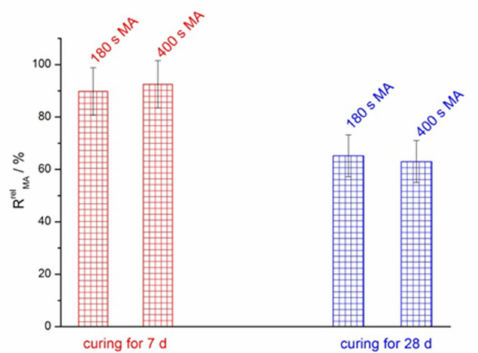
Figure 4. Relative increment of MA in the strength of geopolymers (R rel MA ) at the age of 7 and 28 days.